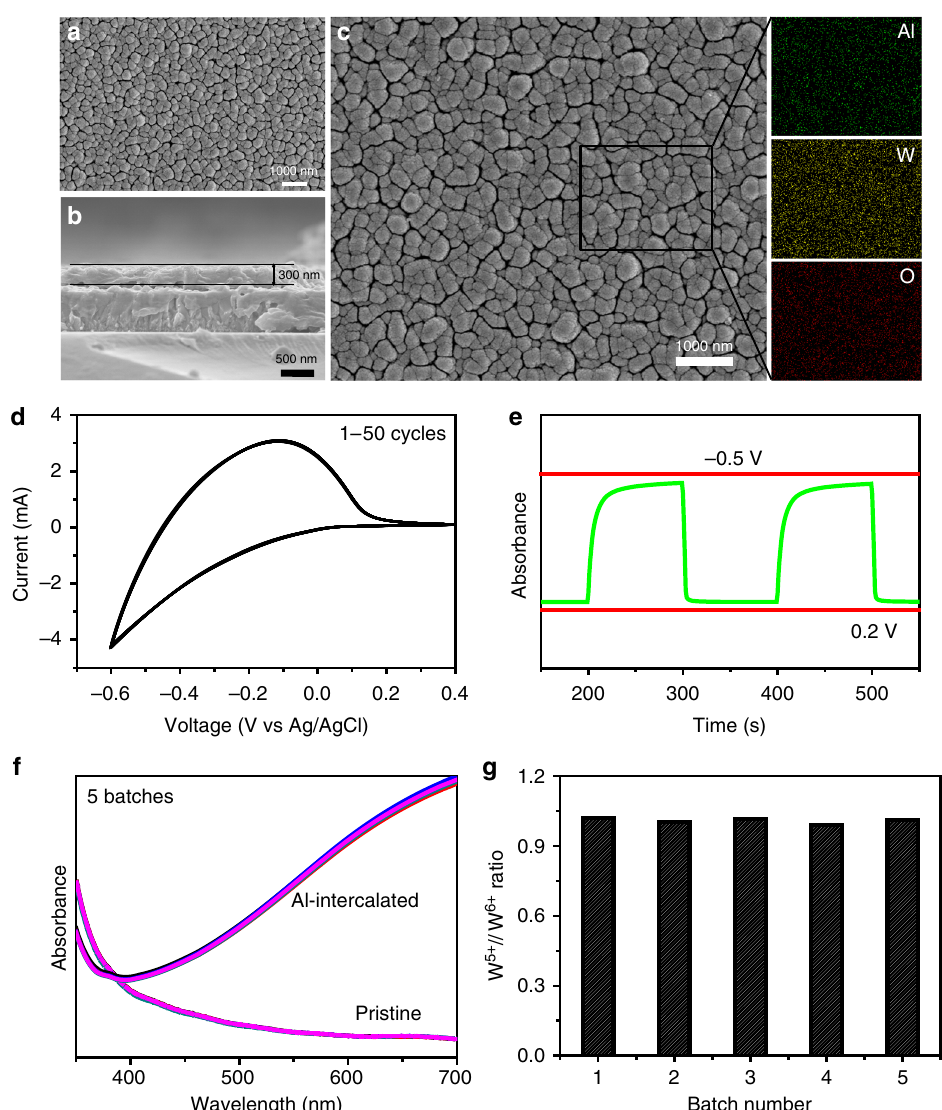
Fig. 1 Composition control of tungsten oxide through Al intercalation. a Top-view and b cross-sectional scanning electron microscopy (SEM) images for the pristine tungsten oxide fi lm on fl uorine-doped tin oxide (FTO) glass. c SEM image of the Al-intercalated tungsten oxide fi lm, and the elemental mapping results of the selected area. d Cyclic voltammogram (CV) pro fi les of the tungsten oxide fi lm for 50 cycles, obtained in 1 M AlCl 3 aqueous analyte at a scan rate of 10 mV/s. The 50 curves are overlapping, suggesting good reversibility. e Absorbance switching monitored at 532 nm for tungsten oxide, with alternating biases switching between − 0.5 and 0.2 V in 1 M AlCl 3 aqueous analyte. f Absorbance spectra taken for tungsten oxide fi lms from fi ve batches, and those after discharging potentiostatically at − 0.5 V for 180 s in 1 M AlCl 3 aqueous analyte. g Ratio of W 5 + /W 6 + calculated from deconvolution of